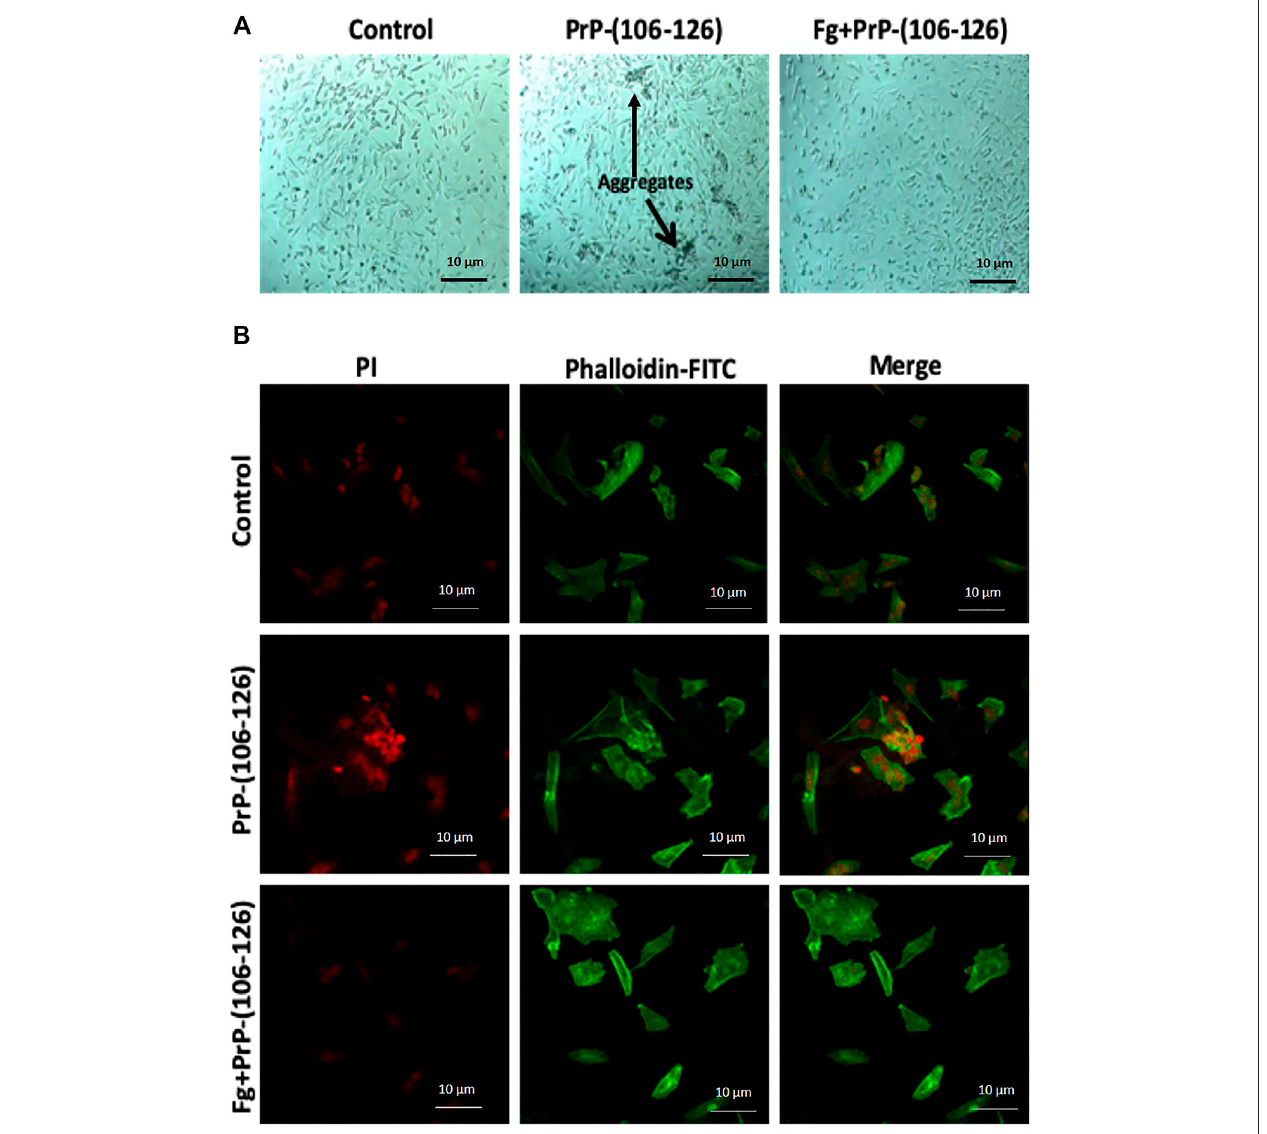
FIGURE 4 | Fibrinogen diminished PrP(106 – 126)-prompted dysmorphic growth of SH-SY5Y cells. (A) SH-SY5Y cells, grown in culture media in presence of PrP and/or fi brinogen as indicated, were observed under phase contrast microscope. Arrows indicate cell aggregates. (B) SH-SY5Y cells, fl uorescently labeled with propidium iodide (red) and phalloidin-FITC (green), were cultured in presence or absence of PrP and fi brinogen as indicated and observed under confocal microscope. Images are representative of fi ve different fi elds each from three independent experiments.